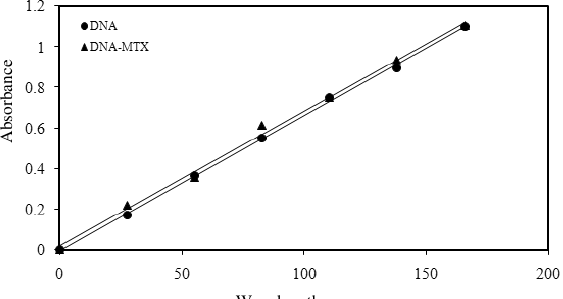
Figure 3. Calibration curves for DNA in the absence and presence of MTX at 260 nm. Conditions: phosphate buffer (0.1 mol L -1 , pH 7.4) plus NaCl (0.1 mol L -1 ), C